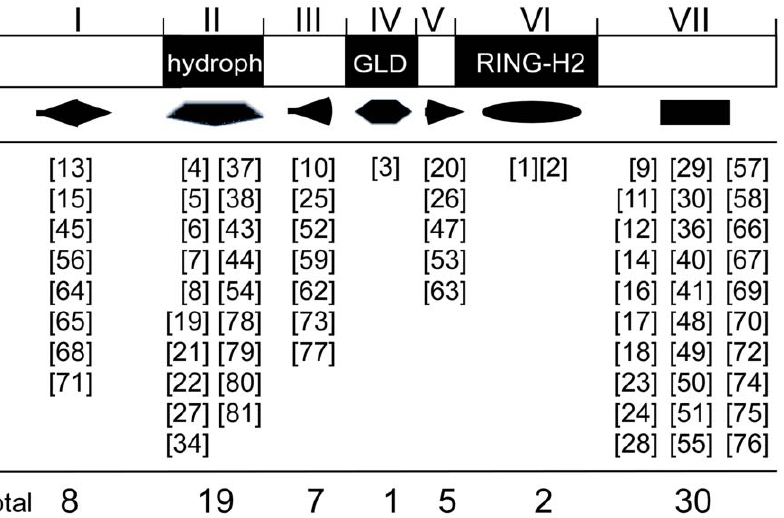
Figure 5. Sequence LOGOs mapped to ATL regions. Below the canonical ATL diagram, geometric figures represent the seven regions and the sequence LOGOs mapped to each region are shown. The total number of logos per region is indicated at the bottom. The catalog of the 75 sequence LOGOs is shown in Table S3.